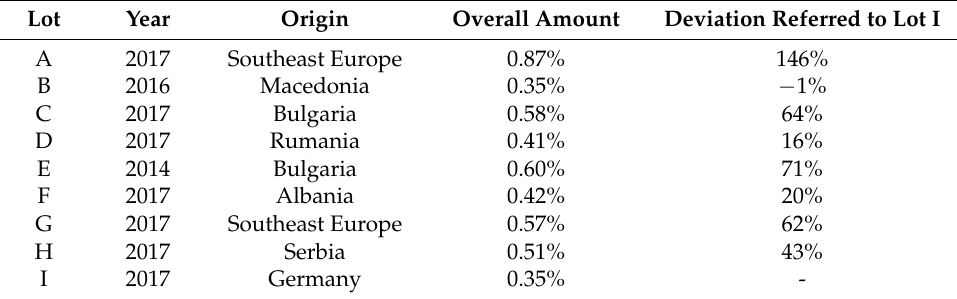
Table 2. Overview of Hawthorn lot variety